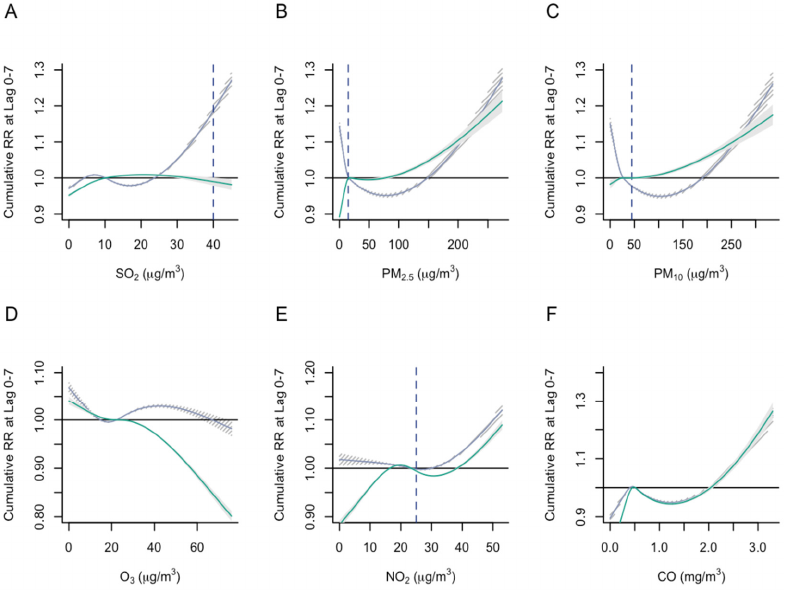
Figure 3. Association between air pollutant levels and cumulative relative risk (RR) of emergency admissions stratified by age group. ( A ) SO 2 levels and RR; ( B ) PM 2.5 levels and RR; ( C ) PM 10 levels and RR; ( D ) O 3 levels and RR; ( E ) NO 2 levels and RR; ( F ) CO levels and RR. The solid gray line represents the modeled cumulative risk for the older adults, while the solid green line represents the modeled cumulative risk for the younger adults. The shaded areas represent the 95% confidence intervals. The horizontal solid black line represents the reference value. The vertical blue dashed line represents the desired air pollutant levels indicated in the WHO air quality guidelines.